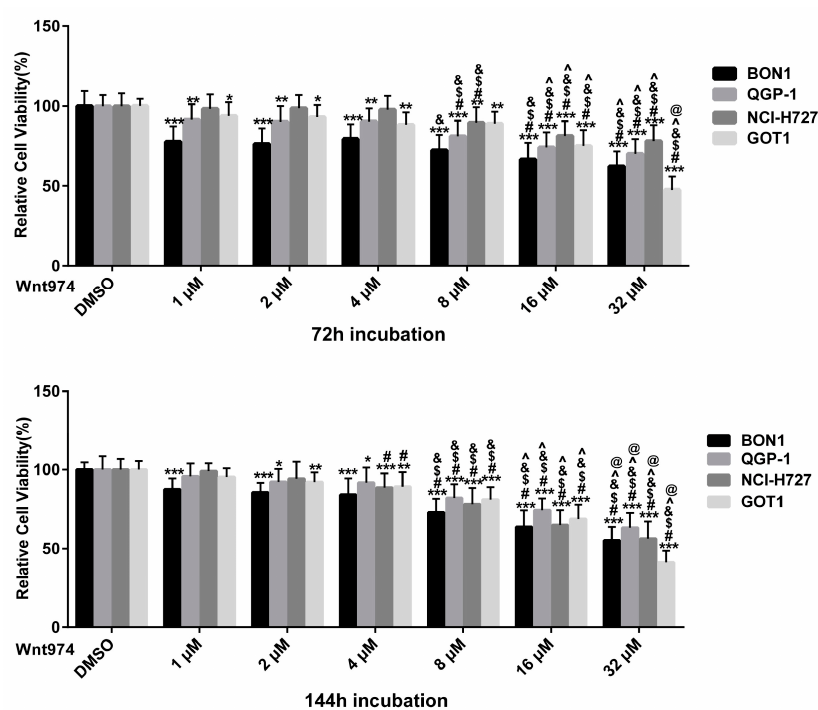
Figure 1. Effect of WNT974 on the reduction of neuroendocrine tumor (NET) cell viability in a dose- and time-dependent manner. The cell viability of human pancreatic BON1 and QGP-1, bronchial NCI-H727, and midgut GOT1 NET cell lines was assessed after treatment with WNT974 compared with that of dimethyl sulfoxide (DMSO) control. The data are expressed as mean ± SD. Each experiment, with technical triplicates, was repeated at least thrice. * p < 0.05, ** p < 0.01, and *** p < 0.001 compared with that of DMSO controls. # p < 0.05 (2 µ M–32 µ M vs. 1 µ M, respectively), $ p < 0.05 (4 µ M–32 µ M vs. 2 µ M respectively), & p < 0.05 (8 µ M–32 µ M vs. 4 µ M respectively), ˆ p < 0.05 (16 µ M–32 µ M vs. 8 µ M respectively), @ p < 0.05 (16 µ M vs. 32 µ